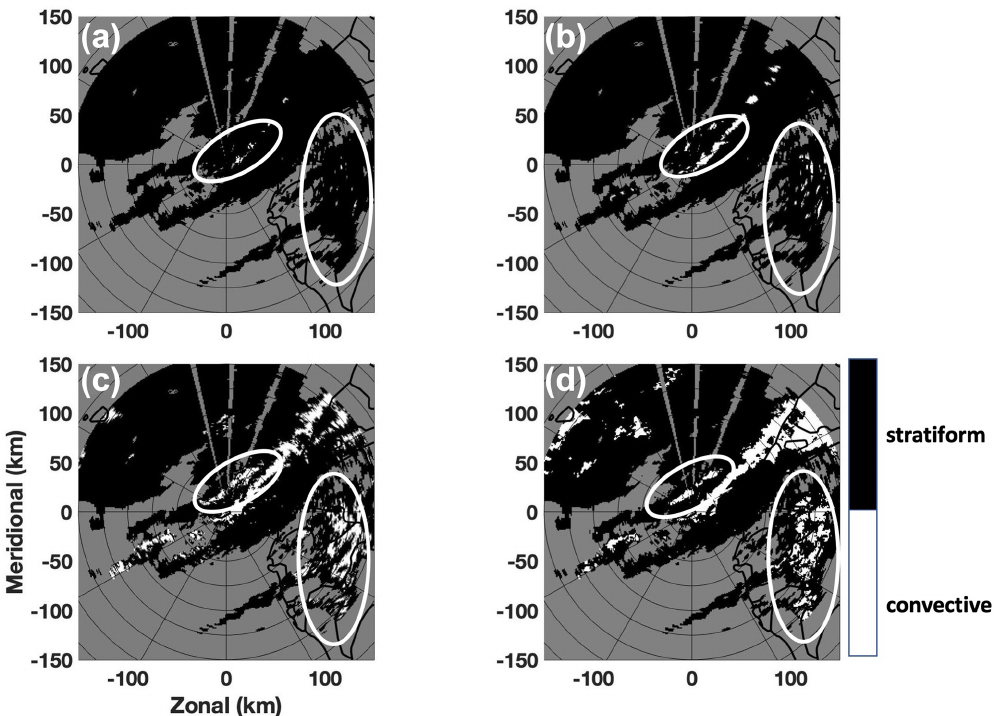
Figure 9. The classification results from BAL 0 (a) , BAL − 0 . 5 (b) , SVM (c) , and MRMS (d) . The time stamp for BAL 0 , BAL − 0 . 5 , and SVM is 04:02UTC, 9 August 2009, and the time stamp for MRMS is 04:00UTC, 9 August